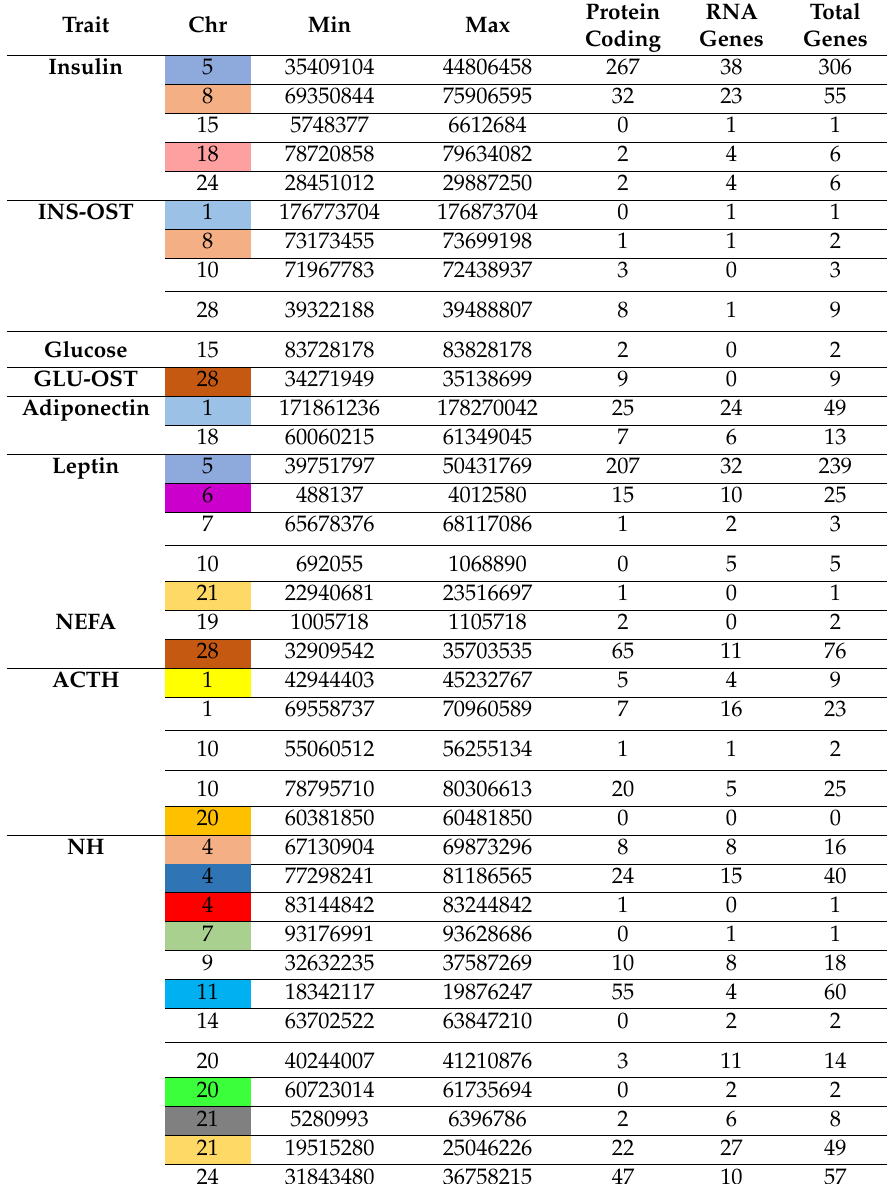
Table 2. LD-bound high priority GWA regions for the Welsh pony